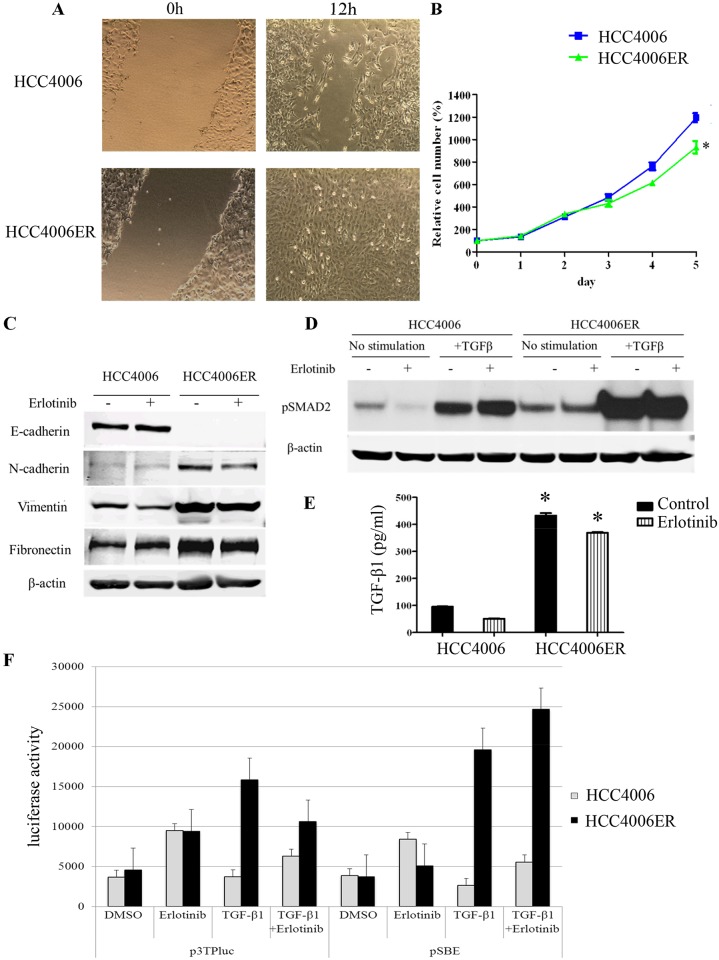
HCC4006ER cells have EMT-phenotype with activation of TGF-β/SMAD signaling.A, Monolayers of HCC4006 and HCC4006ER cells were scraped in a straight line with a 1000-μL pipette tip. Monolayer photos with scratches were taken after 12-hour incubation. B, HCC4006 and HCC4006ER cells were plated at 1x103 cells/well in black wall 96-well plates, incubated in RPMI with 10% FBS, and allowed to grow for indicated days. Data generated by cell viability assay (CellTiter-Glo) are expressed as a percentage of the value for untreated cells. Determinations were done in triplicate. Bars, SEM. *P < 0.0001 for HCC4006 versus HCC4006ER (Student t test). C, HCC4006 and HCC4006ER cells were incubated for 6 hours ± erlotinib (1 μM). Cell lysates were subjected to protein expression analysis with antibodies to E-cadherin, N-cadherin, vimentin, fibronectin, and β-actin. D, HCC4006 and HCC4006ER cells were incubated for 6 hours ± TGF-β1 (10 ng/ml) or erlotinib (1 μM), as indicated. Cell lysates were subjected to protein expression analysis with antibodies to pSMAD2 and to β-actin. E, HCC4006 or HCC4006ER cells were incubated overnight. Medium was replaced with serum-free RPMI with or without erlotinib (1 μM) and incubated for an additional 24 hours. Supernatants were collected and subjected to TGF-β1 ELISA. Determinations were done in triplicate. Bars, SEM. *P < 0.0001 versus HCC4006 cells with or without erlotinib treatment (Student t test). F, TGF-β-induced transcription is increased by co-treatment with TGF-β and erlotonib in transient and transfections with TGF-β-responsive luciferase constructs. HCC4006 and HCC4006ER cells were transiently transfected with p3TP-Lux reporter or pSBE4 and treated with DMSO, 5 ng/mL TGF-β1, 1 μM erlotinib, or a combination of 5 ng/mL TGF-β1 and 1 μM erlotinib for 48 hours. After 48 hours, luciferase activity was determined as described in Materials and Methods.